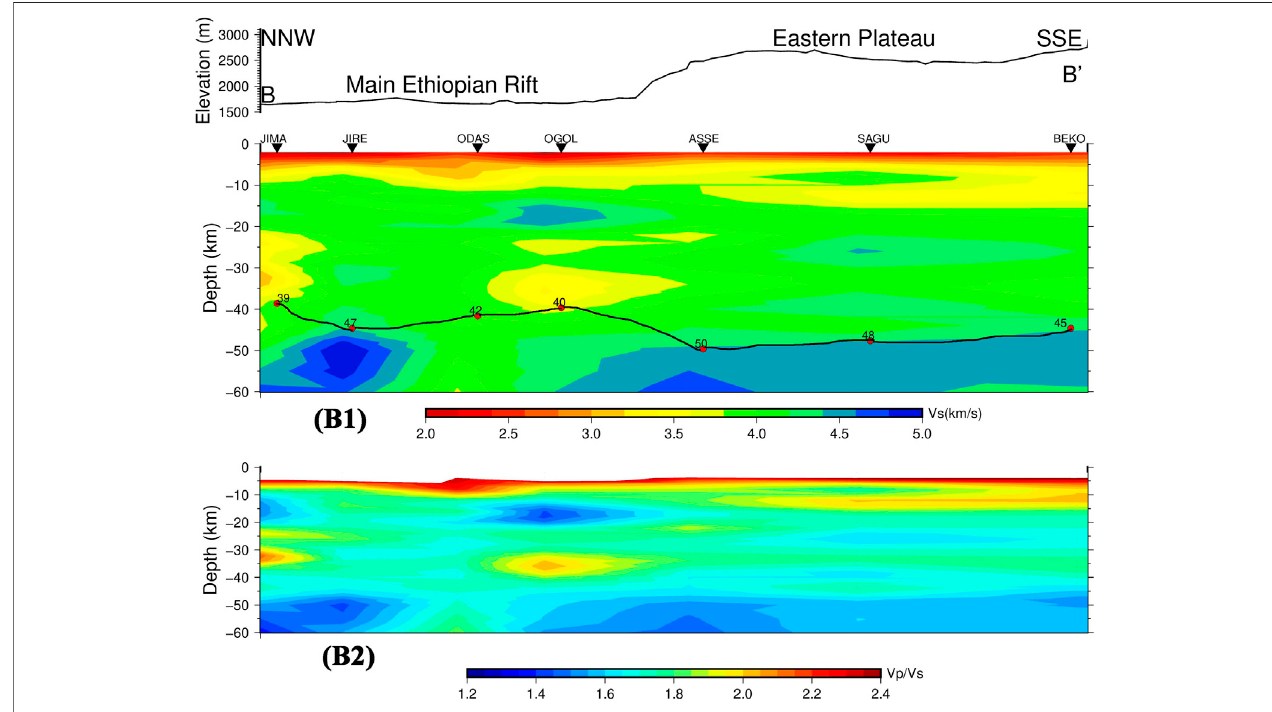
FIGURE 9 | (B1) shows a 2D vertical slice across the rift pro fi le BB ′ of Figure 1 ranging from JIMA (in Central WFB) with an altitude of 1,659 m to BEKO (Eastern Plateau)havinganelevation of2,848 m.Redindicatesslowervelocity andbluefastervelocity. B2 showsthevaluesofVp/Vsfortheriftandtheplateausideofthepro fi le. Blue indicates low Vp/Vs, and red indicates high Vp/Vs